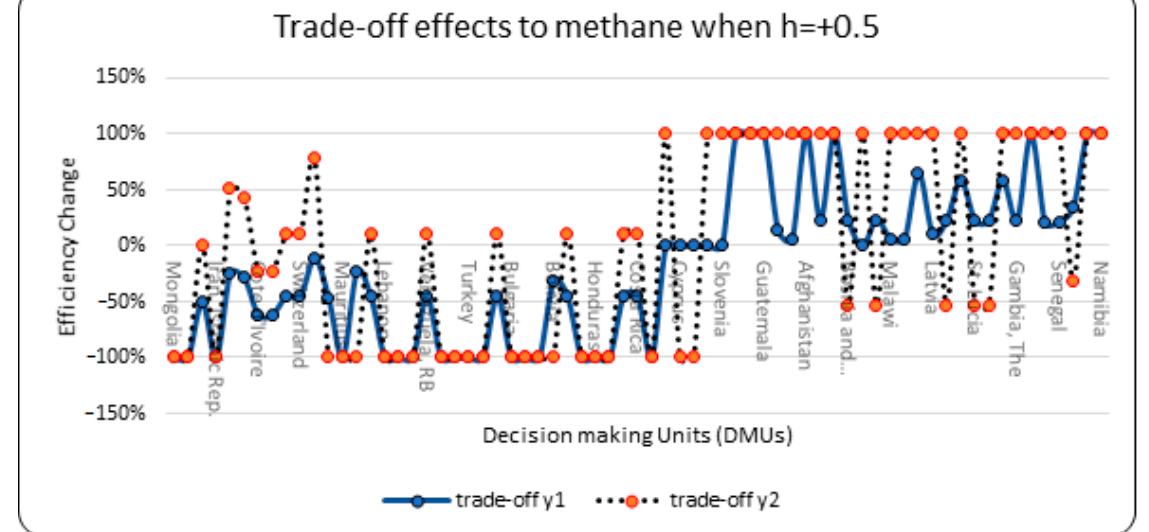
Figure 1. Trade-off effects on methane emissions ( 𝑧 (cid:2869)(cid:3029) ), when ℎ = +0.5 . Next, we look for the effects on methane emissions ( 𝑧 (cid:2869)(cid:3029) ) in Table 6, when the trade-off is applied with ℎ = −0.5 to 𝑦 (cid:2869)(cid:3034) and 𝑦 (cid:2870)(cid:3034) . Again, if we trade-off Austria’s 𝑦 (cid:2869)(cid:3034) with ℎ = −0.5 , i.e., from 49.48 to 48.98, the 𝑧 (cid:2869)(cid:3029)(cid:2879) increases minimal with trade-off rate 𝜏 (cid:2869)(cid:2869)(cid:2879) = 0.0018 , but it decreases as 𝑧 (cid:2869)(cid:3029)(cid:2879) = 45.9624 with trade-off rate 𝜏 (cid:2869)(cid:2870)(cid:2879) = −0.0023 when 𝑦 (cid:2870)(cid:3034) is reduced by ℎ = −0.5 (from 46.99 to 46.49). Pakistan’s situation does not fit this trade-off, as it increases or does not change with 𝑦 (cid:2869)(cid:3034) and 𝑦 (cid:2870)(cid:3034) , respectively. In Iraq’s case, it does not make any difference with either reduction (crop production or forest area). Likewise, all the other DMUs can be checked in Table 6. With this trade-off (i.e., when ℎ = −0.5 ), again we found that 𝑦 (cid:2869)(cid:3034) produces a better result as compared to 𝑦 (cid:2870)(cid:3034) (that is when the crop production is improved as compared to the improvement in the forest area), see Figure 2. It does not imply that the area of crop needs to be expanded. Of course, expending crop area will cause more agricultural erosion and maintenance, rather better production techniques for more production with the same crop area is the answer here.